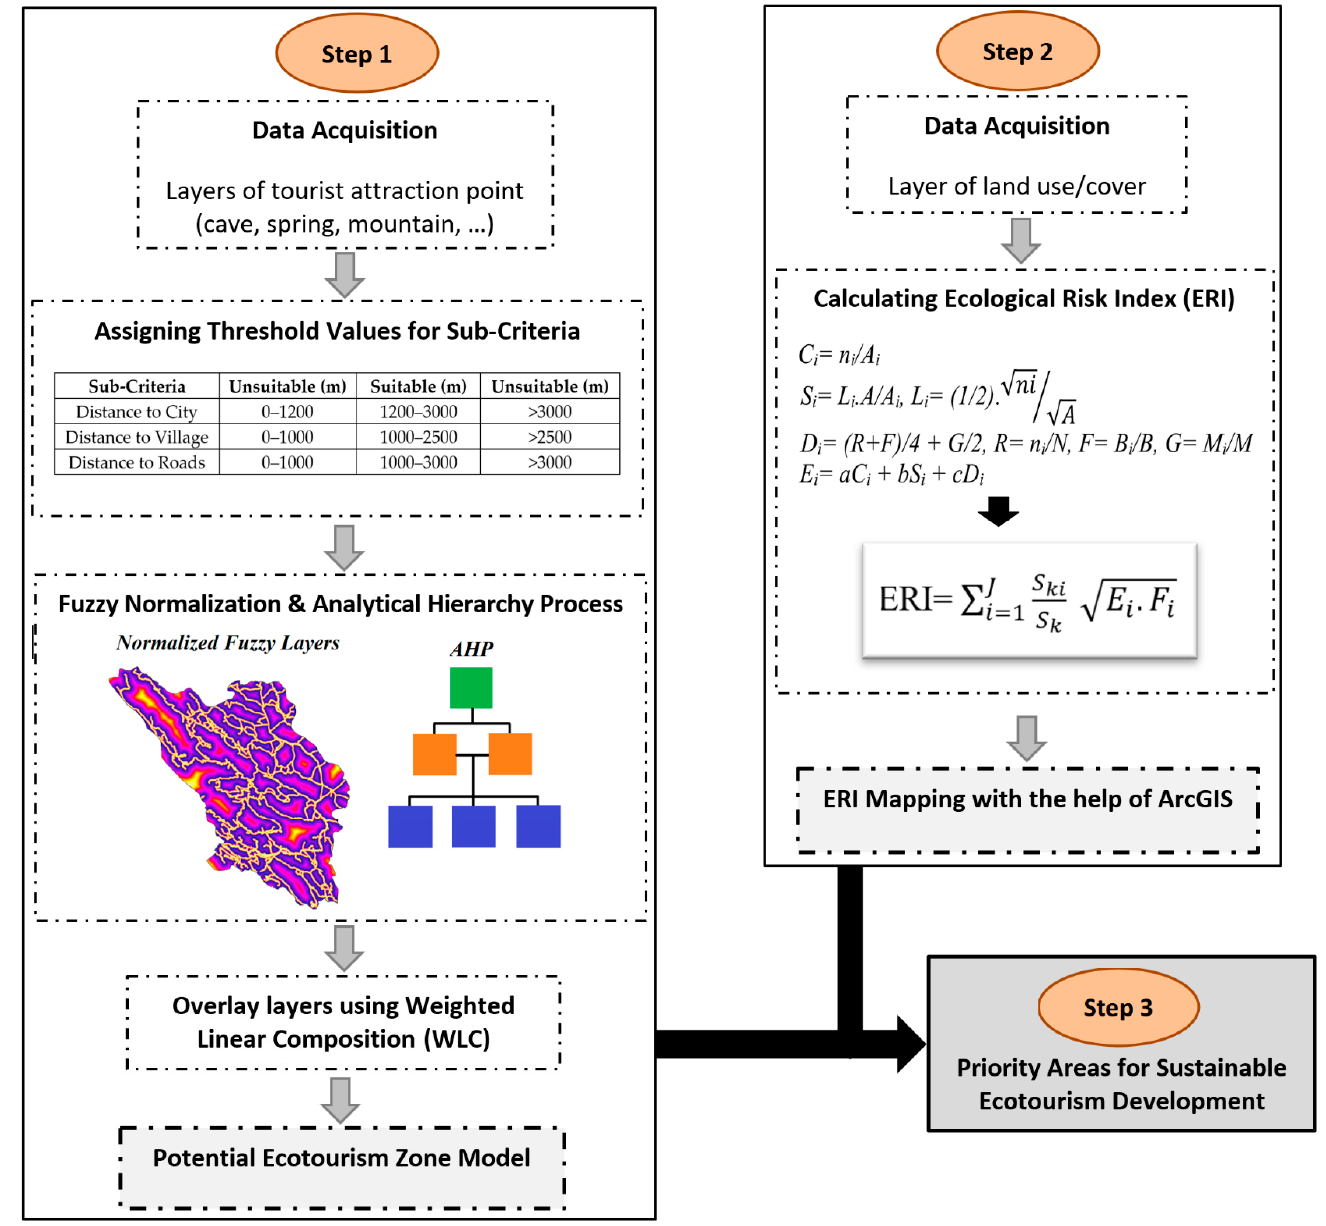
Figure 3. A flowchart illustrating the methodological structure of the present study. 2.2.1. Assessing and Modelling the Potential Ecotourism Zones (See Figure 3, Step